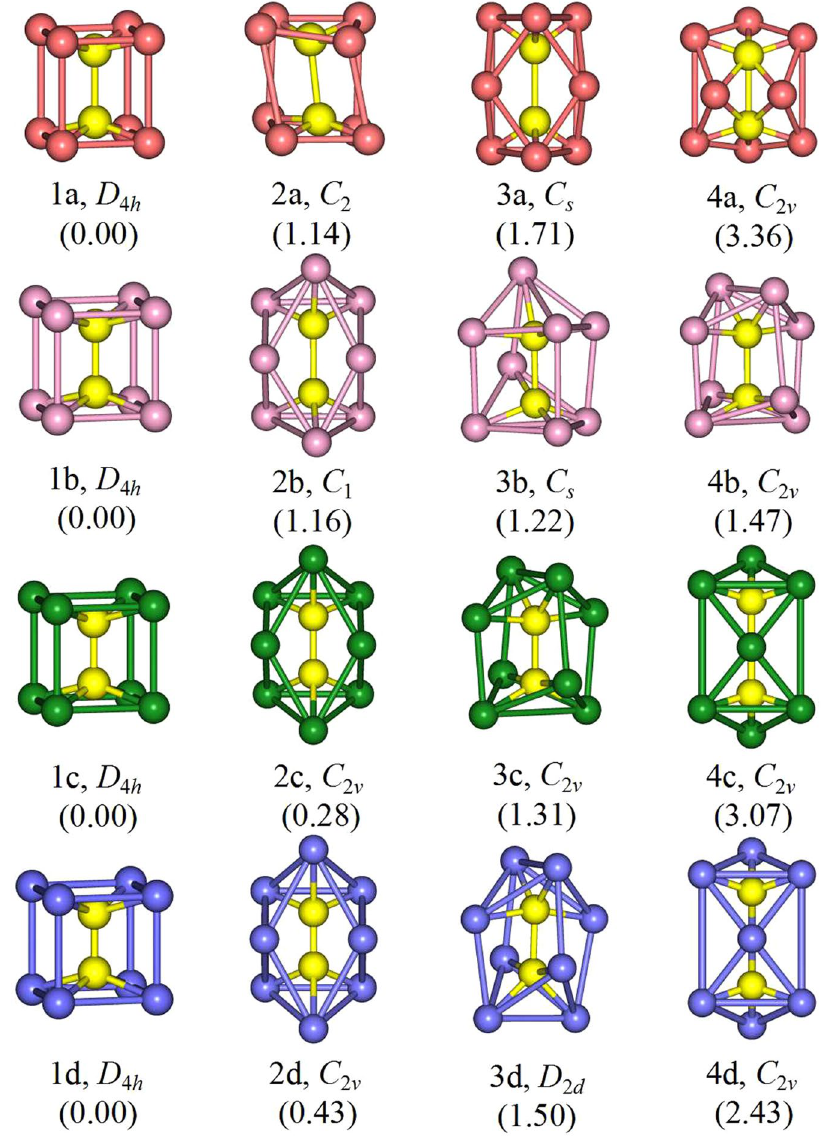
Figure 1. The geometrical structures of low-lying Re 2 X 82 − (X = F, Cl, Br, I) clusters, along with the point group symmetry and relative energy (eV). Rhenium atoms are in yellow. Fluorine, chlorine, bromine and iodine atoms are in orange, pink, green and purple, respectively.